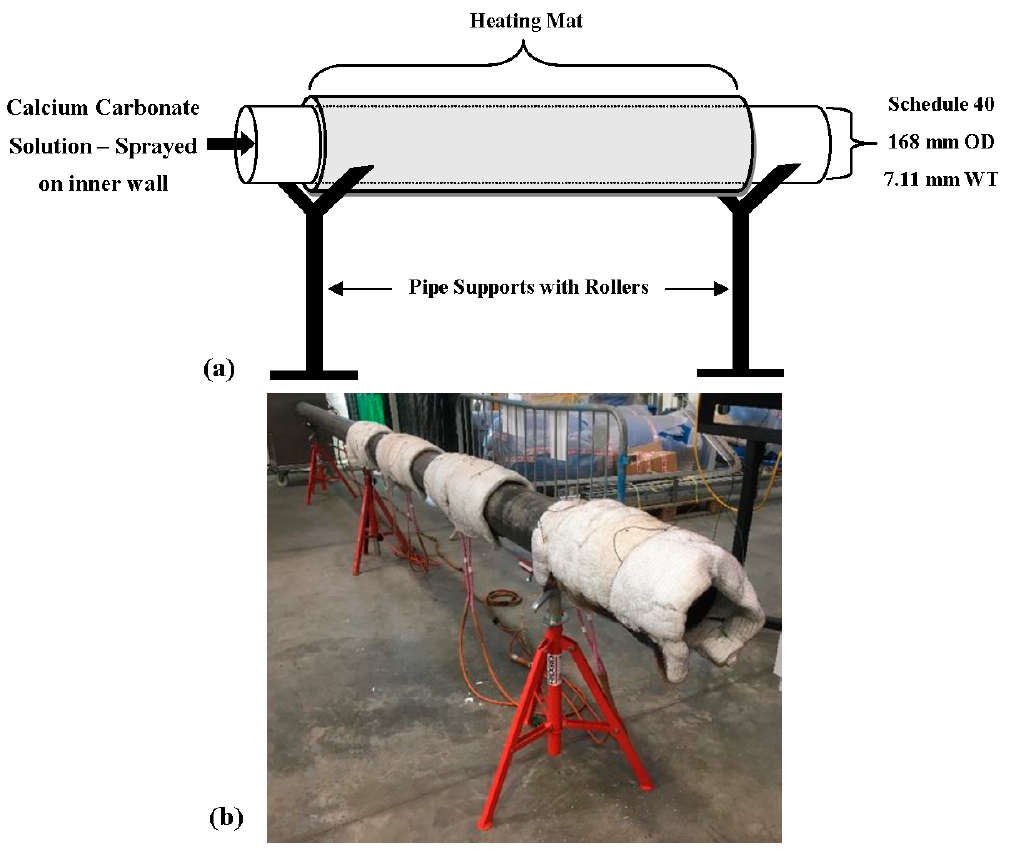
Figure 3. Fouling generation of 6.2-m 6-inch schedule 40 carbon steel pipe ( a ) schematic and ( b ) experimental set-up.